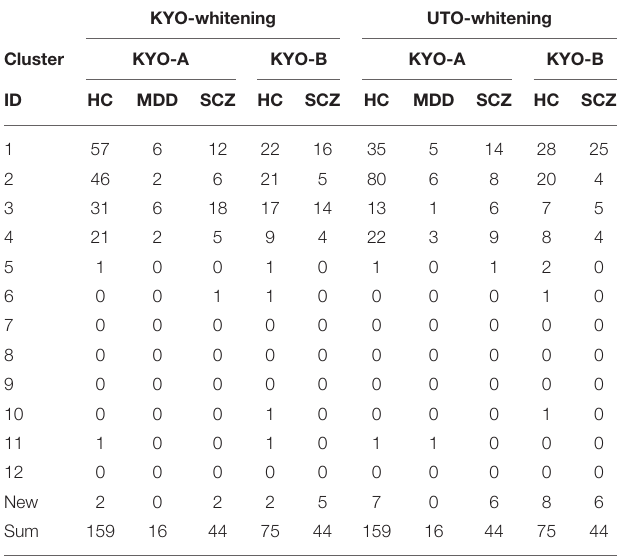
L 1 and L 2 regularization (42). We considered two pre-processing steps: regression-out and non-regression-out of age and sex effects from the